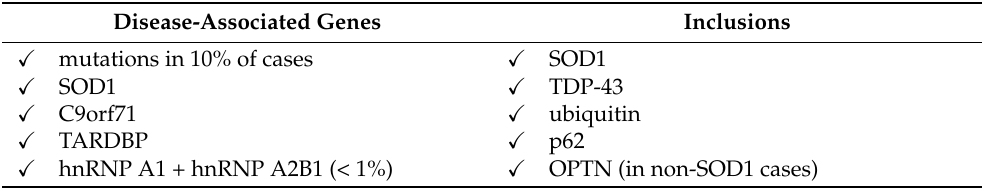
Table 1. Summary of characteristics genes and inclusions in SALS cases.